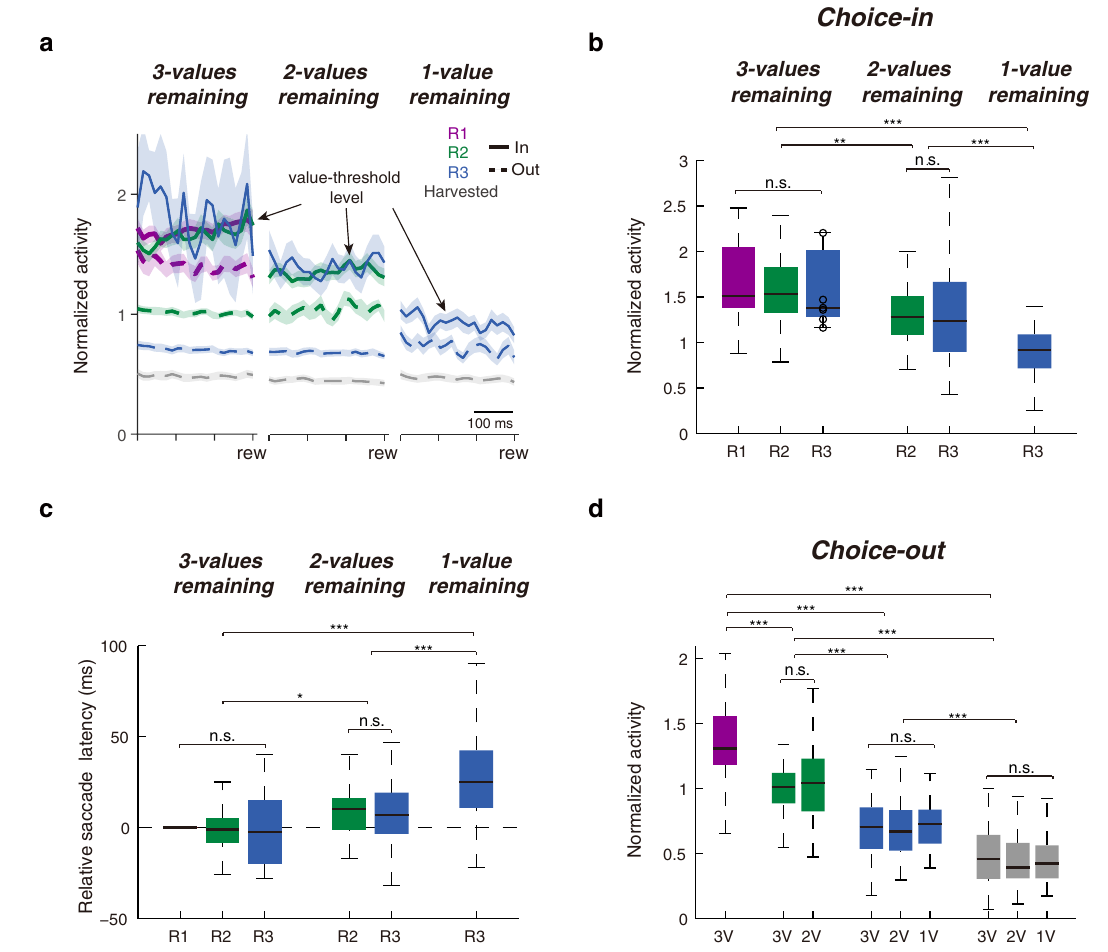
Fig. 5 Menu updating of the value-threshold level and value representations. a Normalized neuronal activity during the late fi xation period (last 300ms before reward delivery, rew). Same format as Fig. 4a. b Neuronal activity associated with choice-in conditions. For conditions from left to right n = 53, 51, 7, 53, 44, and 47 blocks. For multiple-menu comparisons (labeled with any number of *) from left to right P = 2.6×10 − 3 , 5.8× 10 − 8 , 7.7×10 − 5 . c Relative saccade latencies toward different value ranking targets across the 3 menus. All latencies are calculated relative to the 1st value ranking targets in the 3-values remaining menu. For conditions from left to right n = 53, 50, 14, 53, 40, and 53 blocks. For multiple-menu comparisons (labeled with any number of *) from top to down P = 1.7×10 − 10 , 3.4×10 − 7 , 0.011. d Neuronal activity associated with choice-out conditions. For conditions from left to right n = 49, 53, 49, 53, 53, 39, 53, 53, and 53 blocks. For multiple-value comparisons (labeled with any number of *) from top to down P = 8.5×10 − 66 , 3.3×10 − 42 , 4.0×10 − 14 , 1.1×10 − 46 , 1.4×10 − 18 , 4.9×10 − 14 . Data are presented for each value ranking when there were three values (3V), two values (2V), or one value (1V) targets remaining in the array. n in ( b – d ) represents the number of blocks with more than 3 cases for the condition. For ( b – d ), source data are provided as a Source data fi le. For the boxplots, on each box, the central mark is the median, the edges of the box are the 25th and 75th percentiles, and the whiskers extend to the most extreme data points that the algorithm considers not to be outliers. Outliers are data points that are larger than Q3 + 1.5×(Q3 − Q1) or smaller than Q1 − 1.5×(Q3 − Q1), where Q1 and Q3 are the 25th and 75th percentiles, respectively (n.s., nonsigni fi cant, * P <0.05, ** P <0.01, *** P <0.001; n-way ANOVA tests, post hoc tests were done with Bonferroni